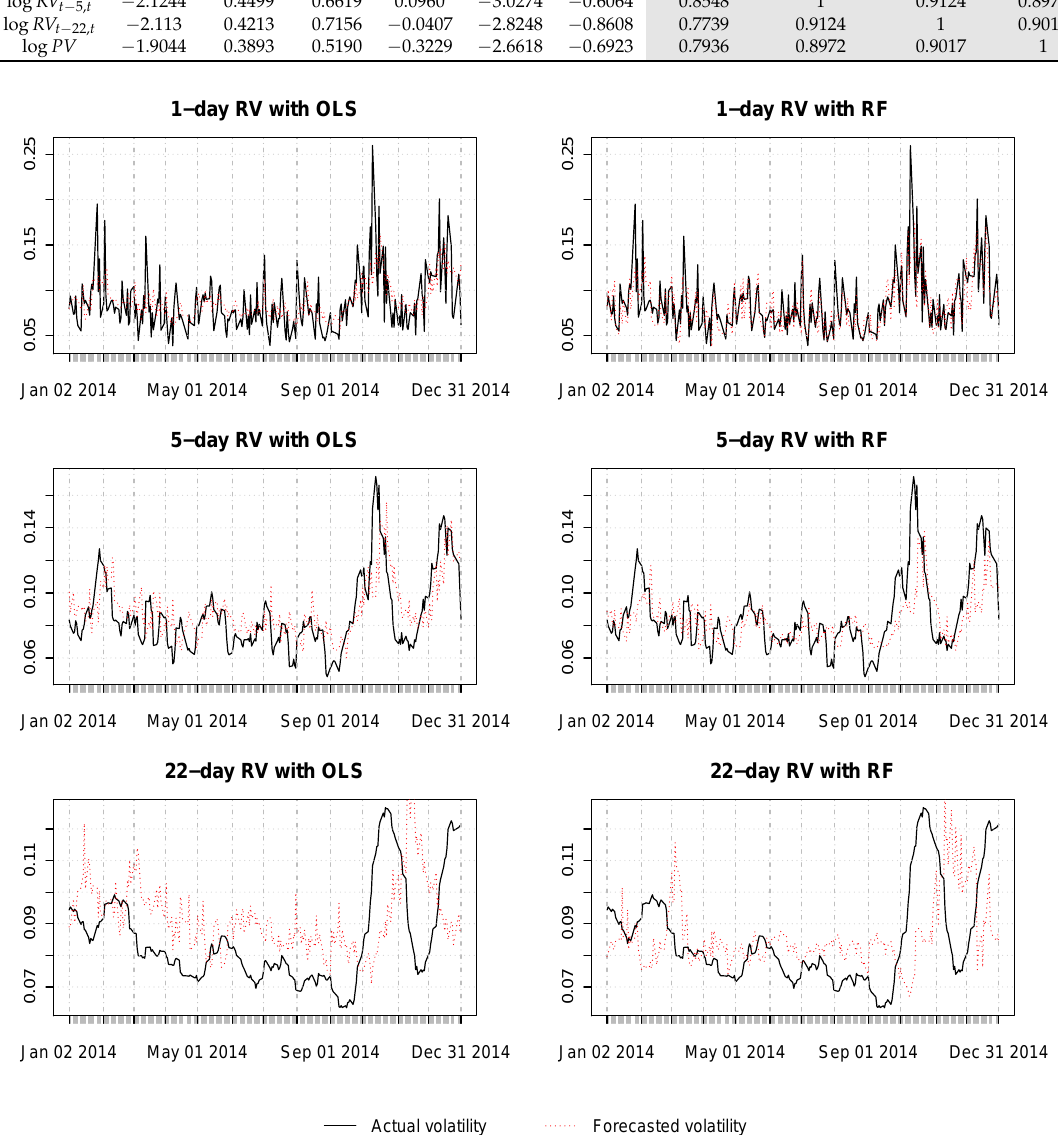
Figure 3. Predicted vs. actual realised volatility using the HAR-JL-PV-D model with the maximum Figure 3: Predicted vs Actual realised volatility using HAR-JL-PV-D model with maximum likelihood estimation and random forests estimation. likelihood estimation and random forests